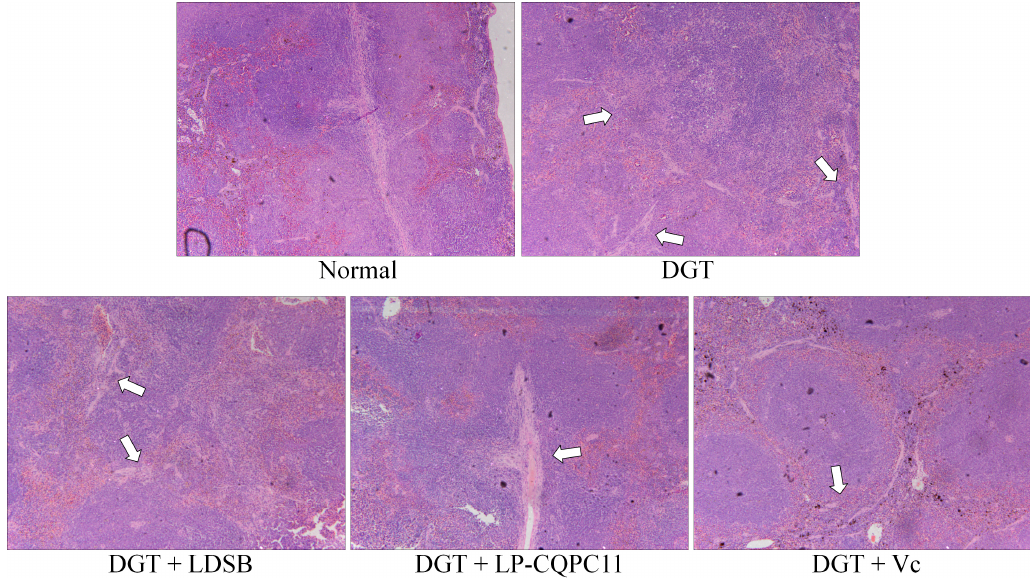
Figure 3. H&E pathological observation of spleen in mice. Magnification 100 × . DGT: mice treated with D -galactose; DGT + LDSB: mice treated with D -galactose and Lactobacillus delbruechii subsp . bulgaricus